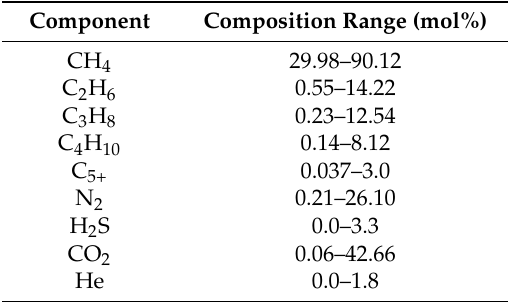
Table 1. Typical composition of raw natural gas [1,2].